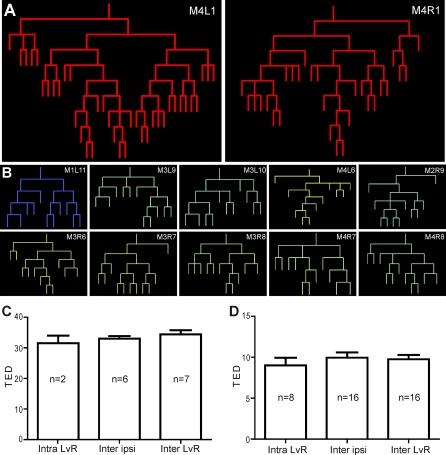
Topological Variability among Corresponding Axons(A) The largest motor units (M4L1 and M4R1), shown as dendrograms, exhibited different topological structures.(B) Ten motor units with identical motor unit size (11 NMJs) from six muscles all had different topologies. The color differences between panels indicate that these axons ranked slightly differently in their respective connectomes.(C) TED between the largest motor units in six muscles was not significantly different among the three groups: intra-animal left versus right pairs, inter-nimal ipsi-lateral (left-left or right-right) pairs, and interanimal left versus right pairs (one-way ANOVA, p = 0.45).(D) TED between medium-sized axons with the same motor unit size (n = 11 NMJ) in six muscles was not significantly different among the same three groups (one-way ANOVA, p = 0.67). Error bars: standard deviation.